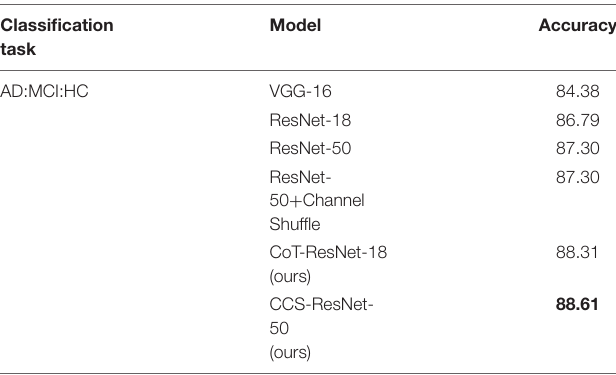
TABLE 8 | Experimental results of classification of MRI data.